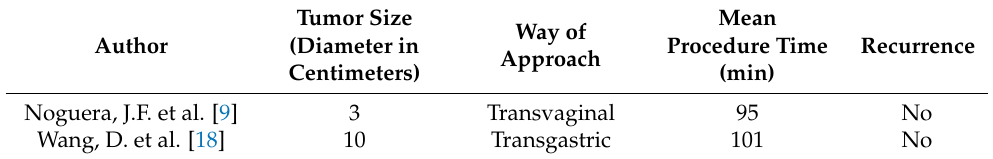
Table 3. NOTES: analysis of intraoperative characteristics, approach and postoperative recurrence.